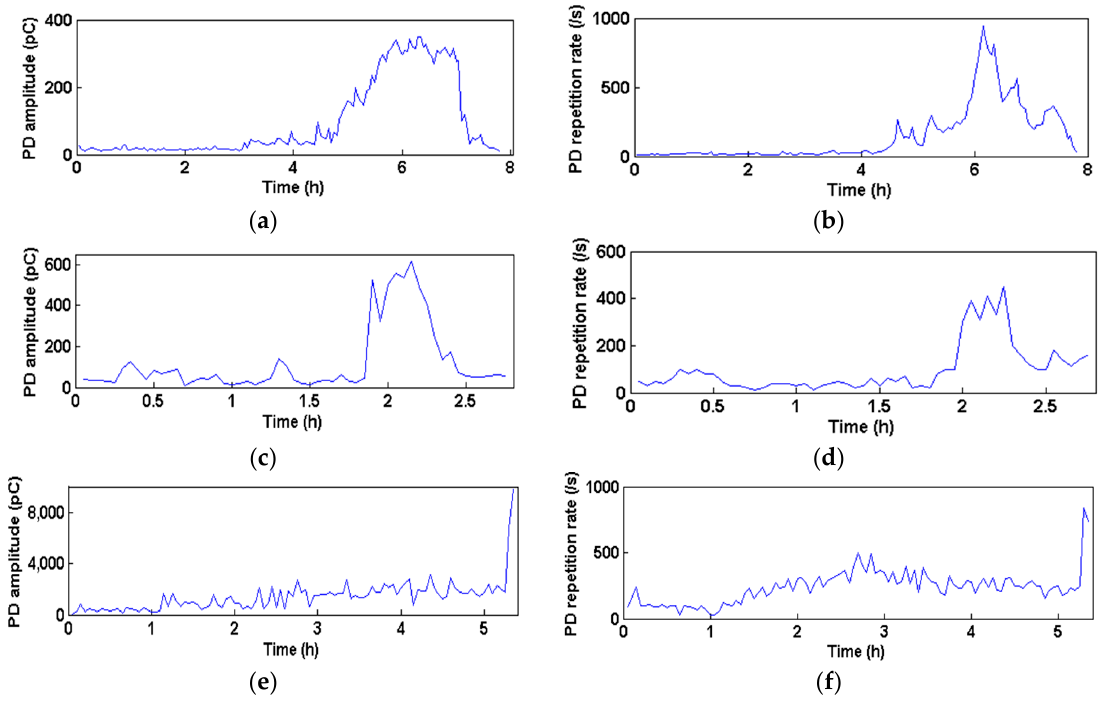
Figure 5. Time-variation trends of Q max and N of three models. ( a ) Q max of needle-plate; ( b ) N of needle-plate; ( c ) Q max of surface discharge; ( d ) N of surface discharge; ( e ) Q max of air gap; ( f ) N of air gap.